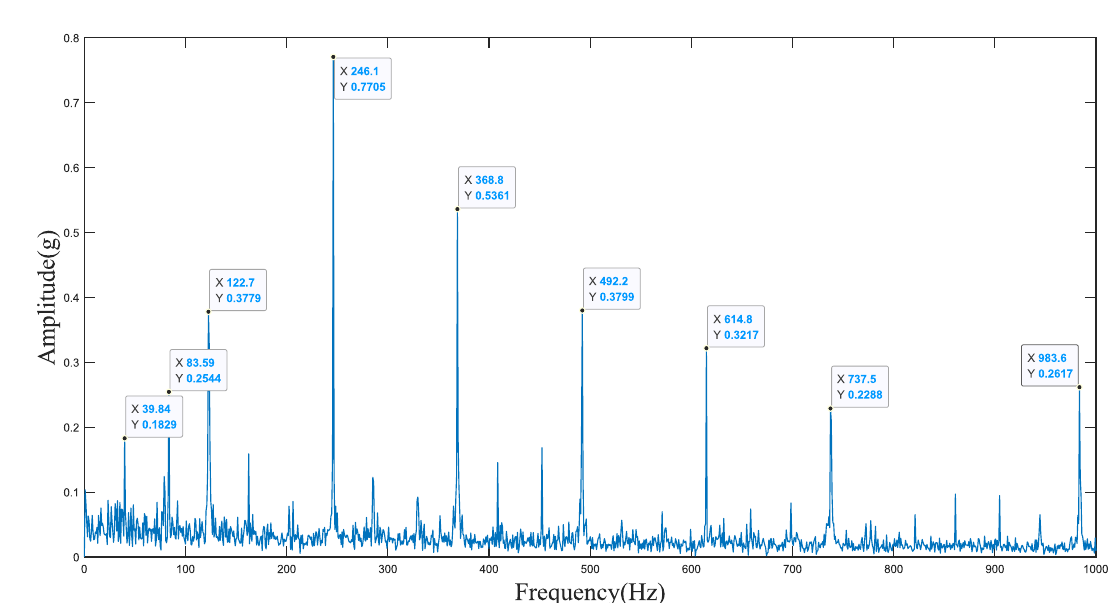
Figure 10. Hilbert-envelope full-vector spectrum.